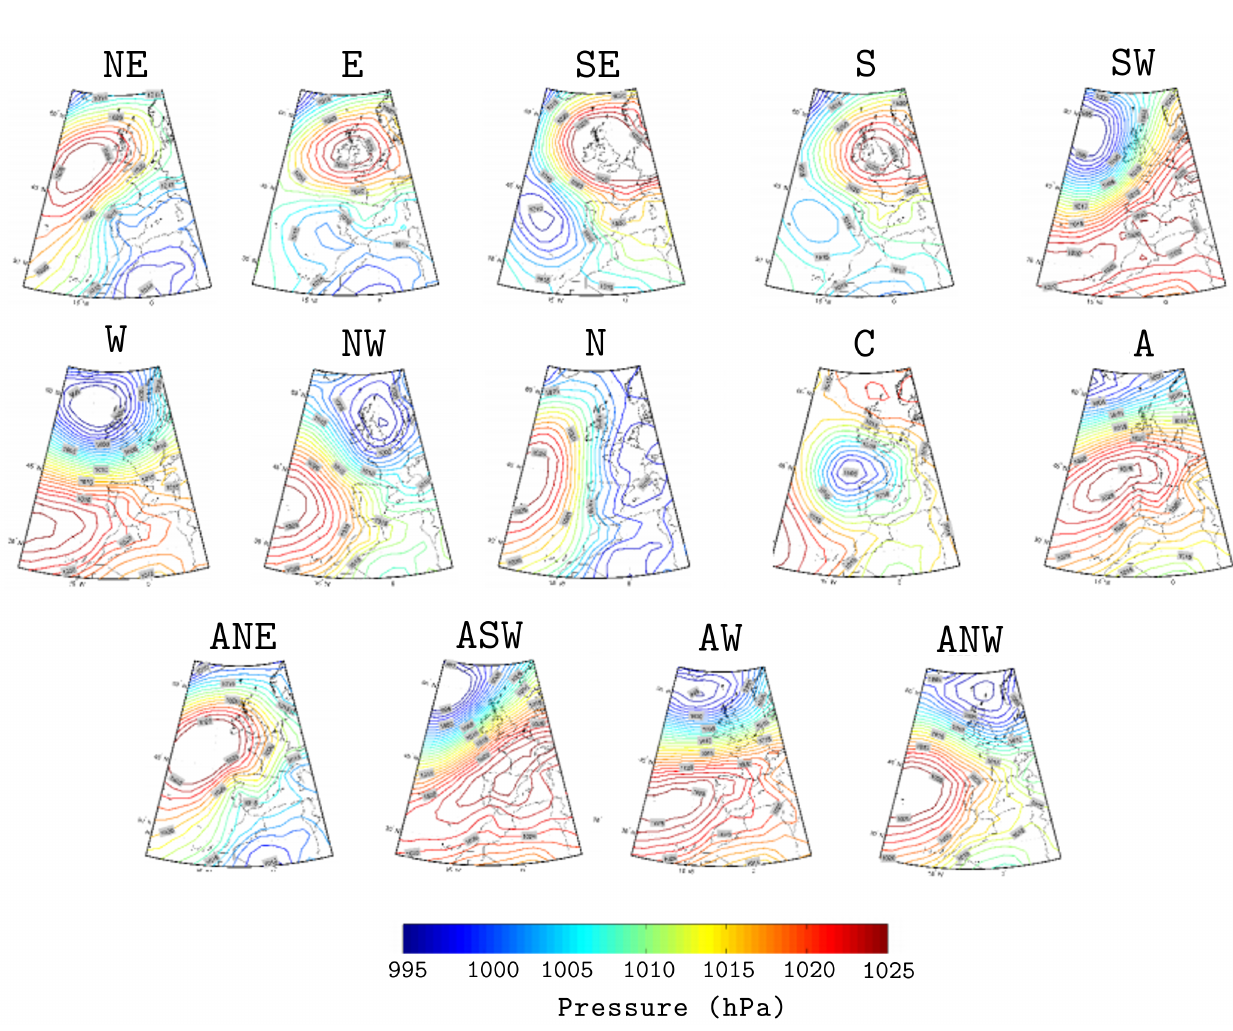
cipitation in the extended summer months for these